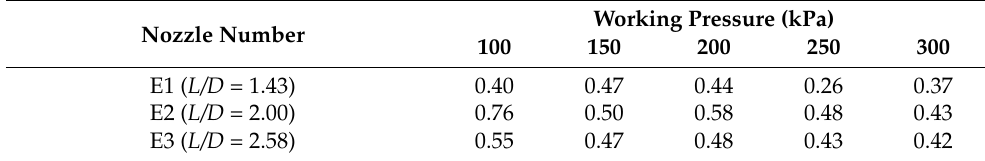
Table 5. Coefficient of variation for elliptical nozzles with different L/Ds